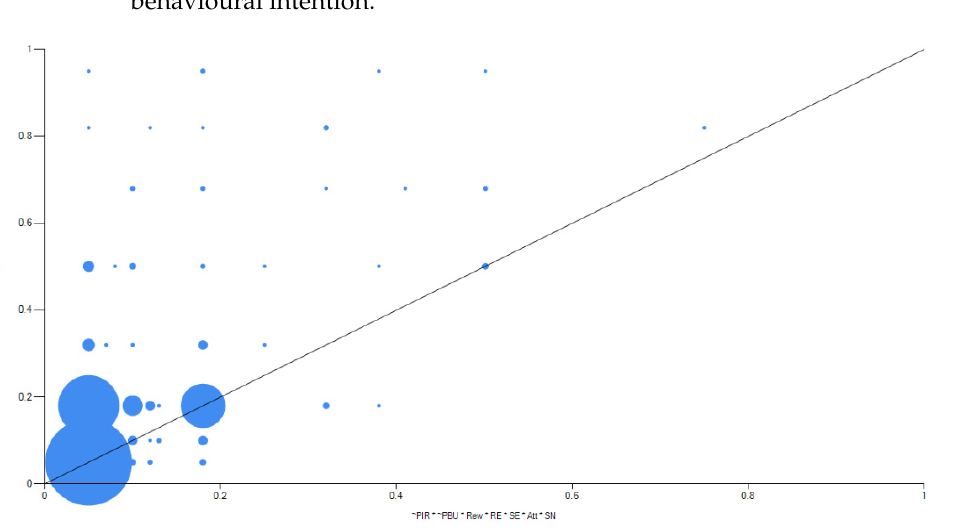
Figure 2. XY plot of M1 for H-BIR.